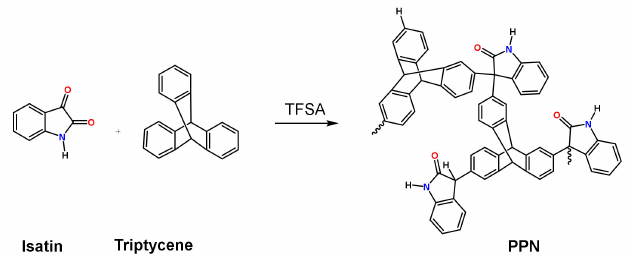
Figure 2. PPN derived from triptycene and isatin.